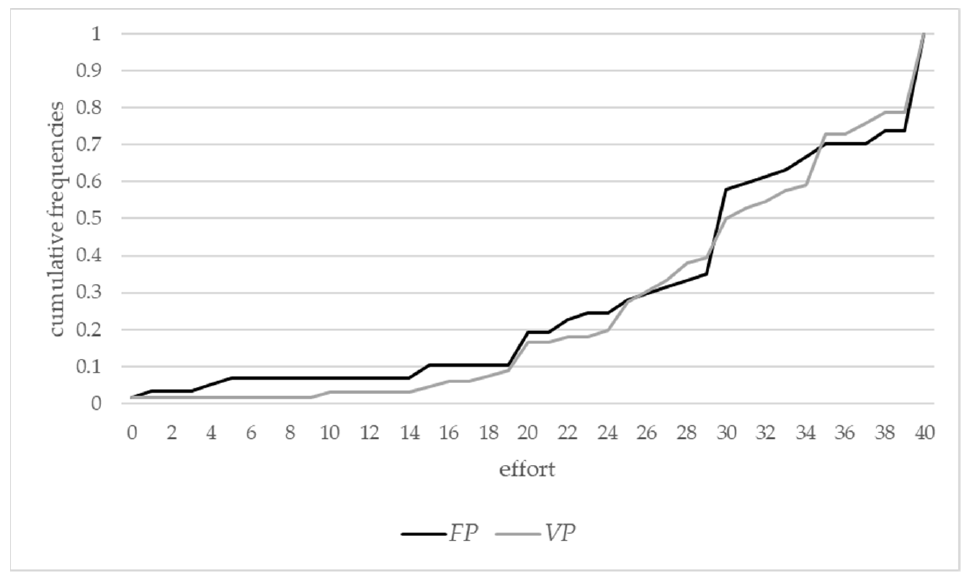
8 of 21 Figure 1. Average effort choices in 𝐹𝑃 vs. 𝑉𝑃 .